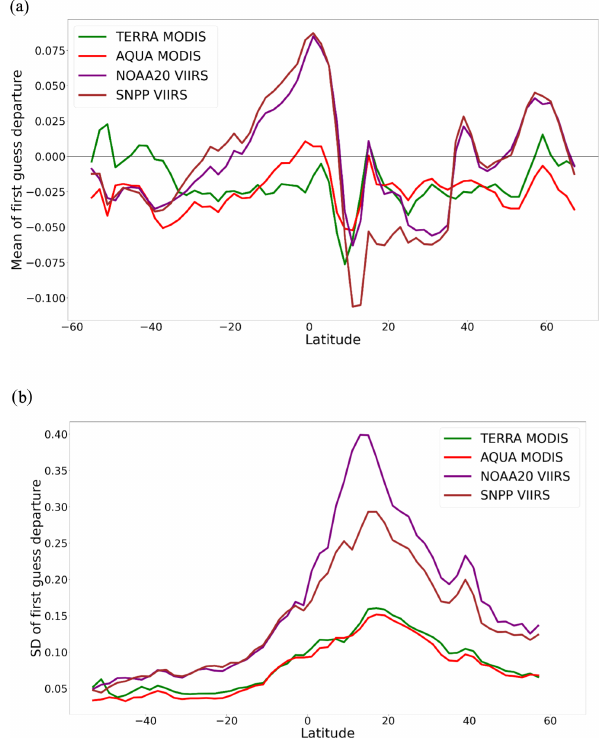
Figure D8. Latitude cross-section of the mean (a) and SD (b) of the first-guess departure for the MAM (2019–2020) period over